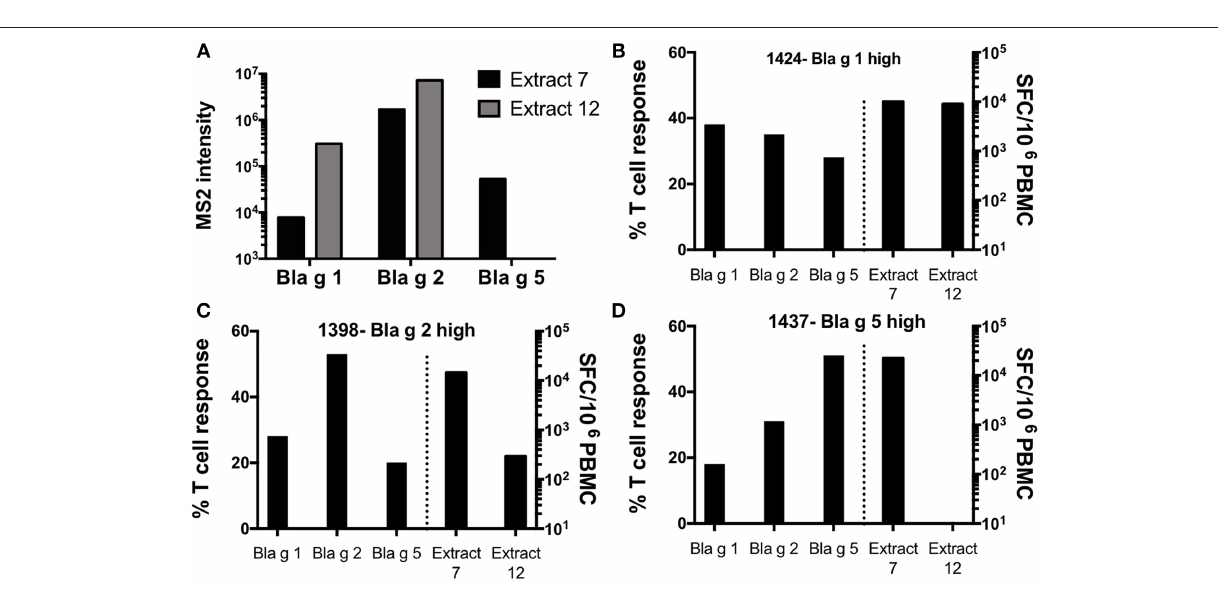
FIGURE 6 | Content of Bla g 1, 2, and 5 and T cell reactivity in response to two selected German cockroach extracts. (A) Content of Bla g 1, 2, and 5 in extract 7 and 12 as measured by mass spectrometry. (B–D) Total T cell reactivity (sum of IL-5, IFN γ and IL-10) against Bla g 1, 2, and 5 -specific peptide pools and extracts 7 and 12 in three different donors, each dominant for either (B) Bla g 1 (donor 1424), (C) Bla g 2 (donor 1398) or (D) Bla g 5 (donor 1437). Bla g pool responses and extract responses are segregated by a dashed line. The left axis applies to the Bla g pool responses (left panel), showing percent of T cell response attributed to each individual Bla g pool. The right axis applies to the extract responses (right panel), showing T cell response magnitude as measured by spot forming cells